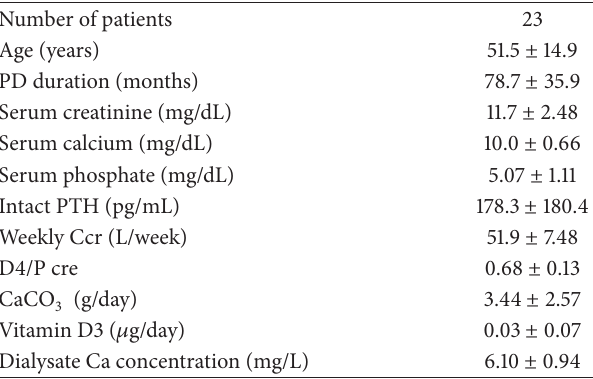
Table 1: Characteristics of